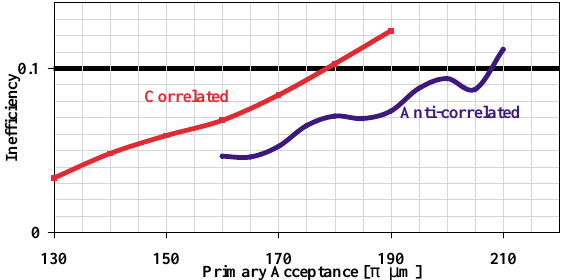
FIG. 13. (Color) Cleaning efficiency as a function of the primary aperture for both cases, correlated and anticorrelated painting. Secondary collimators are fixed at 300 p mm mrad.